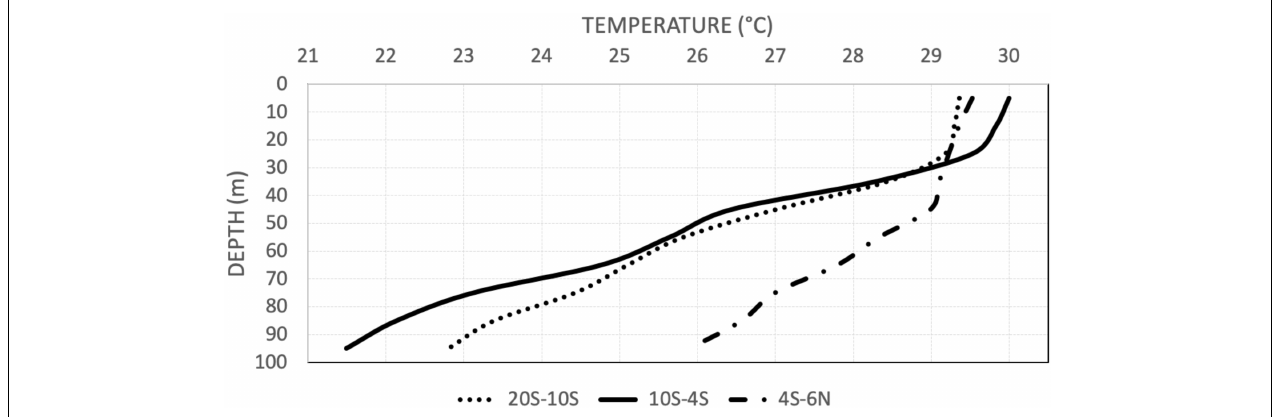
FIGURE 5 | Mean vertical profiles of ocean temperatures in 10 m steps, as deduced from data collected by ST SAMSON (10/02–29/04 2019) and BRICE (7/04–10/07 2019) within latitude bands LB1 [20 ◦ S–11 ◦ S] (dash), LB2 [11 ◦ S–3 ◦ S] (plain) and LB3 [3 ◦ S–7 ◦ N] (long dash) shown in Figure 2 .